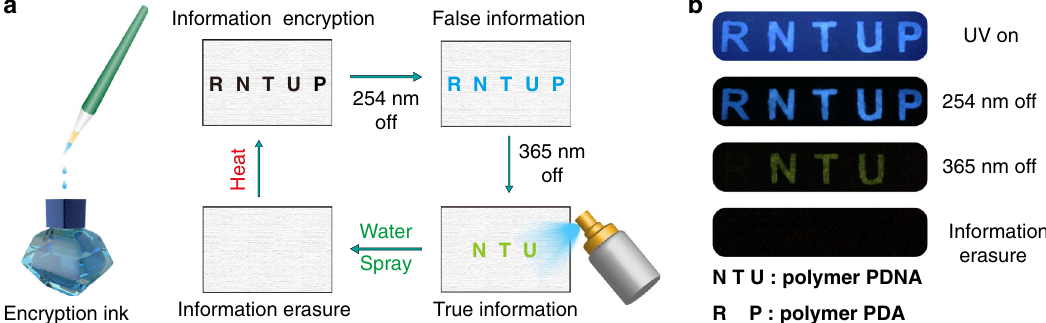
Fig. 5 Description of color-tunable UOP for multilevel information encryption. a Process of information encryption by using the multi-component copolymer PDNA (NTU) and PDA (RP) as encryption ink under ambient conditions. b Long-lived luminescence photographs of letters (RNTUP and NTU) before and after switching off the UV light of 254 and 365 nm,